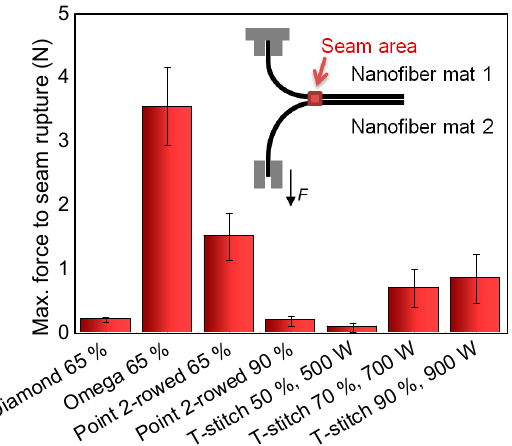
Figure 9. Maximum forces to seam rupture, measured for different ultrasonic welding patterns and pressures. Inset: measurement principle.